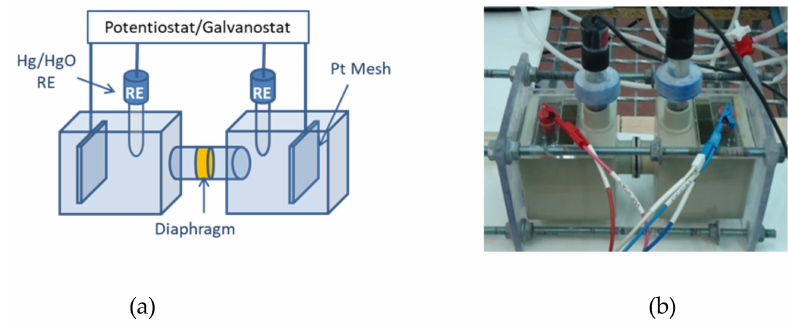
Figure 2. Direct Current Measurement Setup: ( a ) Scheme ( b ) Real